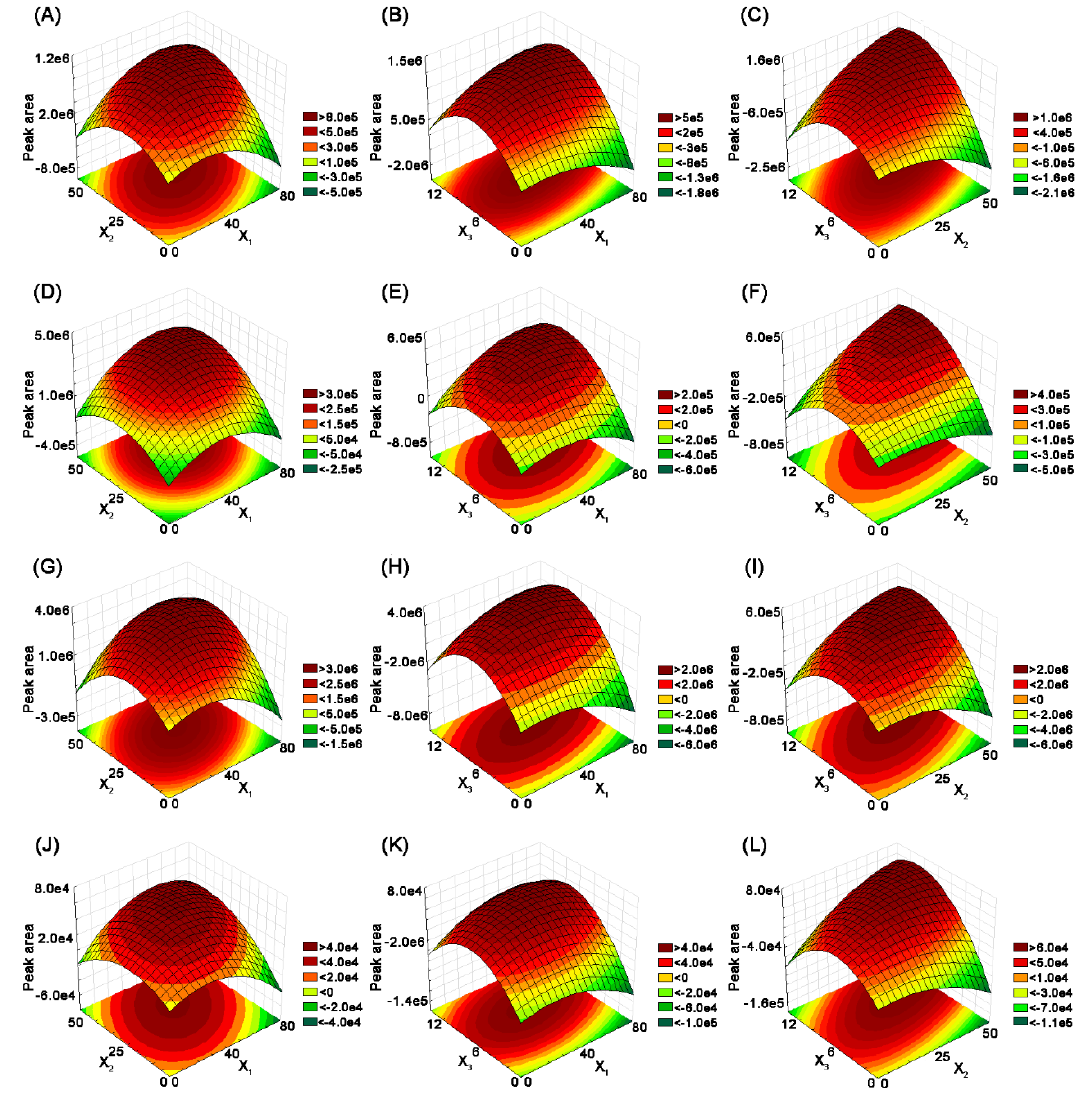
Figure 4. Response surface plots of ( A , D , G , J ) extraction time (X 1 ) and temperature (X 2 ) at a constant solid / liquid ratio (X 3 ) of 1:7, ( B ) extraction time (X 1 ) and solid / liquid ratio (X 3 ) at a constant extraction temperature (X 2 ) of 27.5 ◦ C, ( C ) extraction temperature (X 2 ) and solid / liquid ratio (X 3 ) at a constant time (X 1 ) of 40 min (for ( A , B , C )—epigallocatechin (EGC), ( D , E , F )—epigallocatechin gallate (EGCG), ( G , H , I )—gallocatechin gallate (GCG), ( J , K , L )—epicatechin gallate (ECG)).